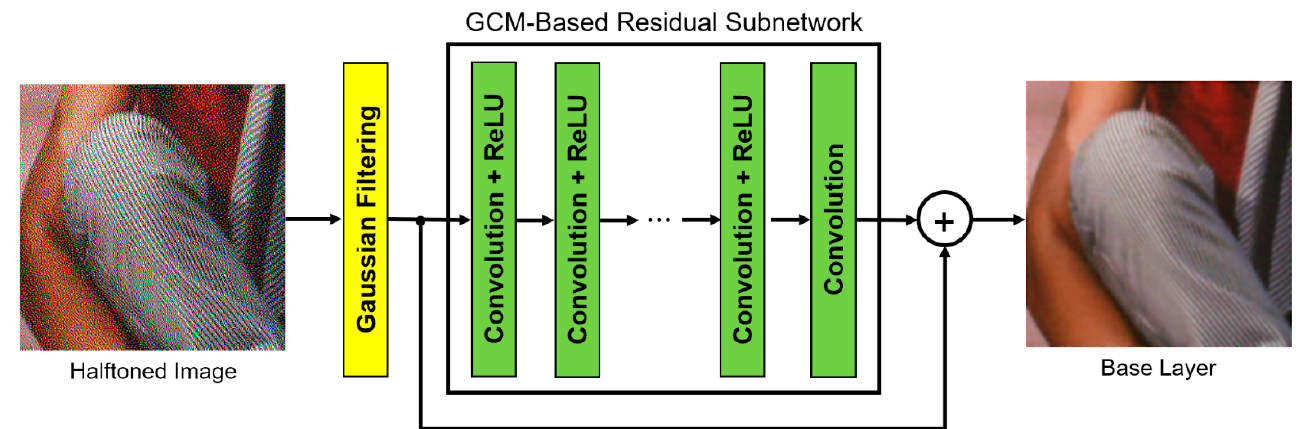
Figure 4. GCM-based residual subnetwork for base layer